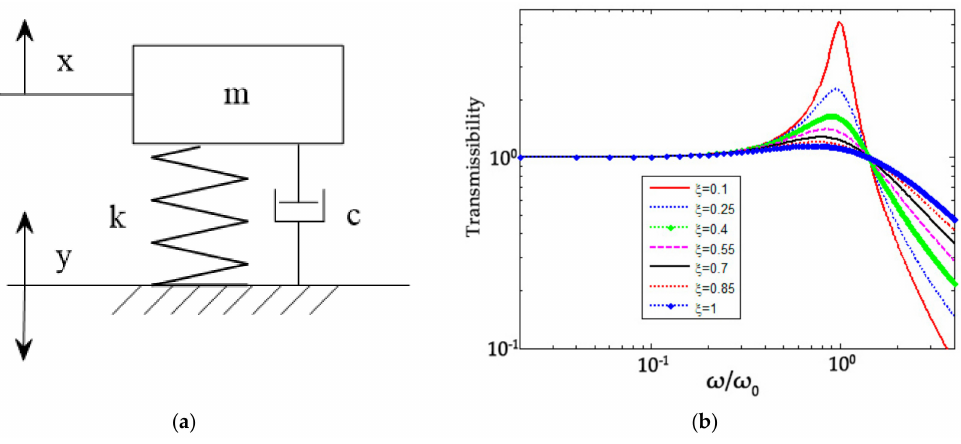
Figure 3. Single-Degree-of-Freedom (SDF) system: ( a ) SDF system schematic; ( b ) SDF